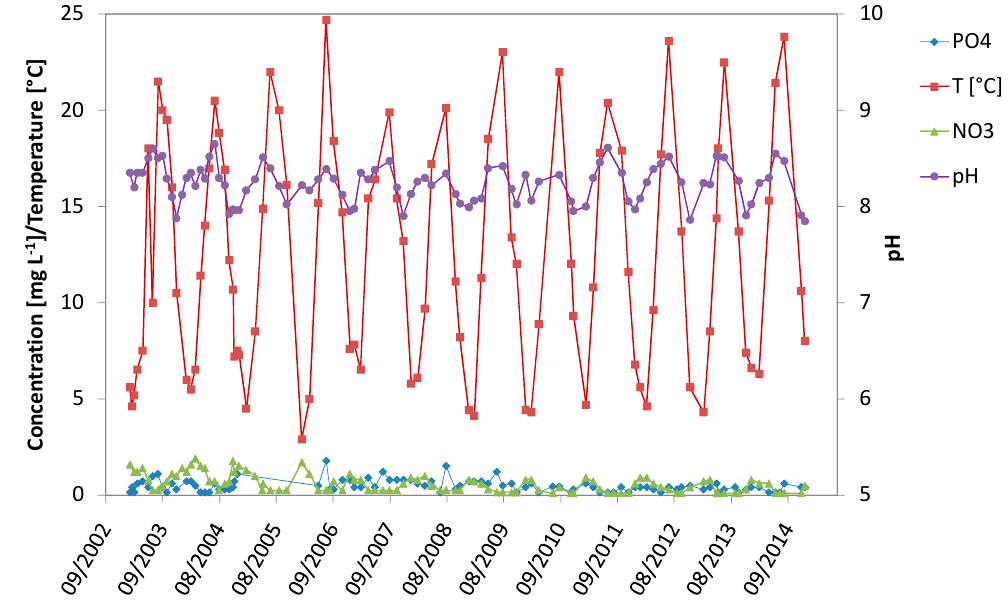
Figure 4. Temperature, pH, NO 3 and PO 4 data of BP Lake from 2003 to 2014. Maximum values of temperature, pH and PO 4 typically occur in summer while maximum NO 3 vales are observed in winter.